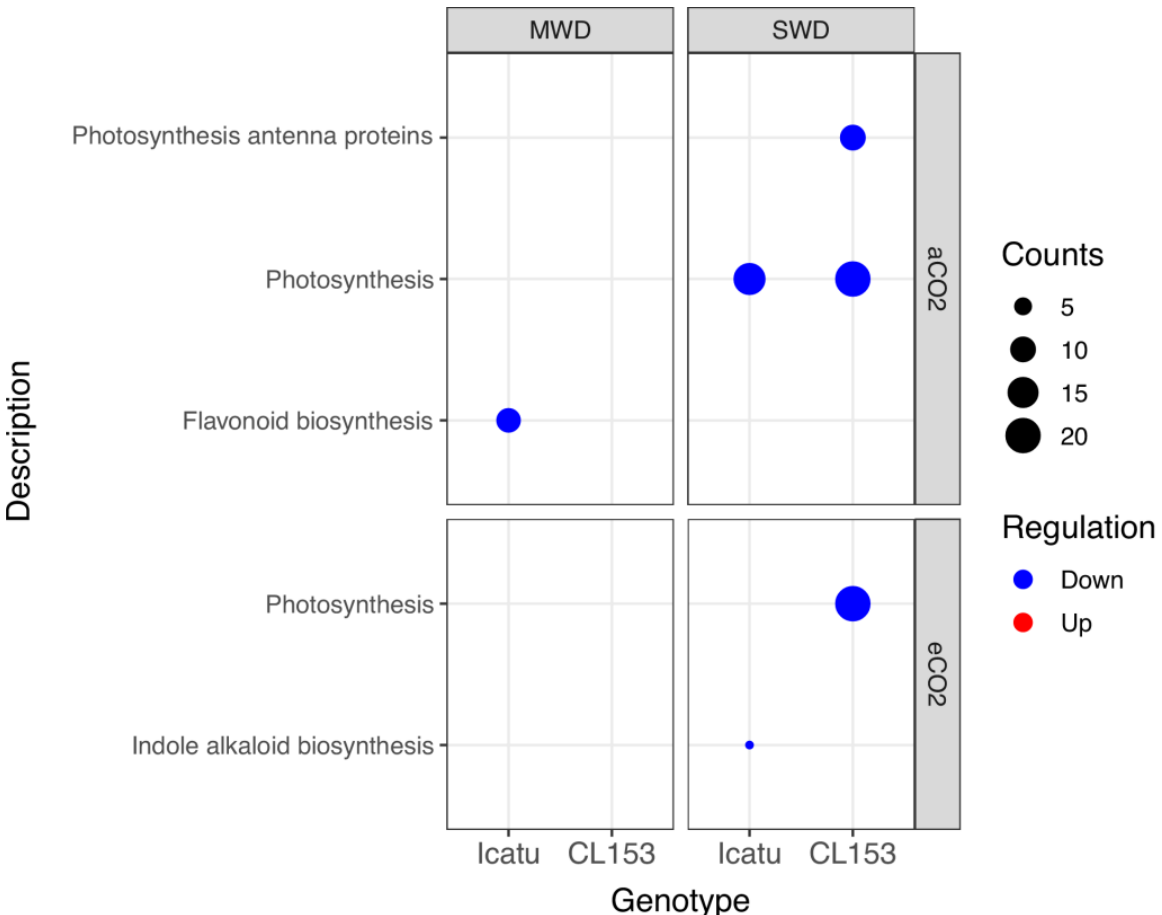
Figure 7. Over-representation analysis of KEGG pathways of Icatu and CL153 down-regulated DEGs performed with gProfiler, using the DEGs’ Arabidopsis thaliana homologs mapped through blastx, against the functional annotation of its reference genome. Significantly (g:SCS < 0.01) enriched KEGG pathways of DEGs ranked by decreasing log 2 fold-change (FC), considering the effect of MWD or SWD in comparison with WW plants grown under aCO 2 or eCO 2 , at 25/20 ◦ C (day/night). Counts (size) indicate the number of DEGs annotated with each GO term. An absence of data in CL153 indicates the absence of significant KEGG pathways.